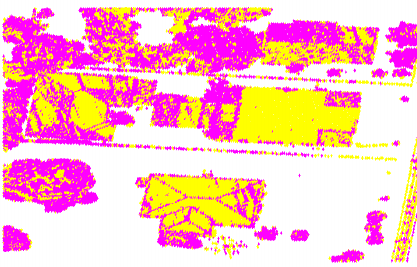
Figure 3: Coplanar and non-coplanar points for a data set: copla- nar (yellow dots) and non-coplanar (magenta dots) LiDAR points.